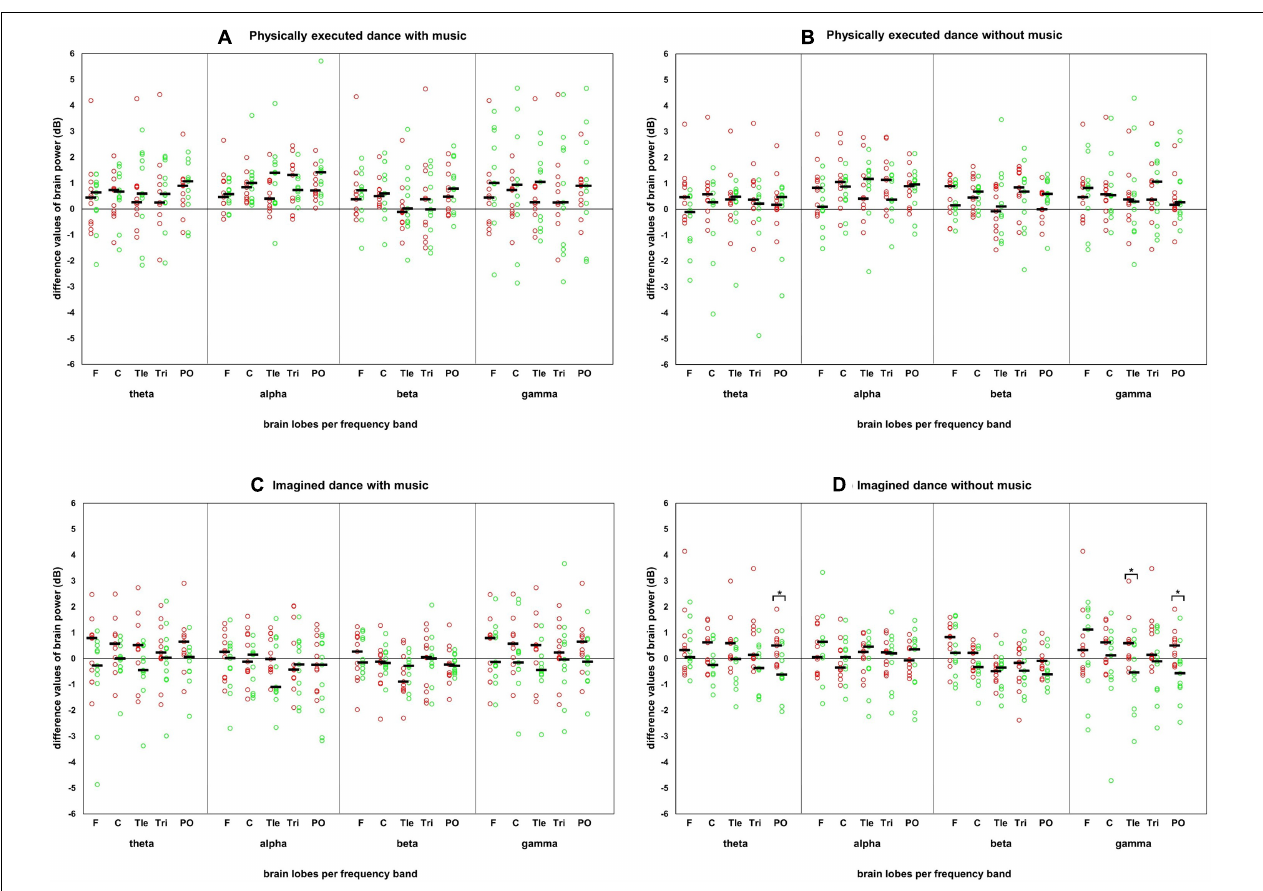
FIGURE 2 | Difference values of each participant in the test conditions in the power spectrum. Difference values of each participant in each test condition, frequency band, and brain lobe in the power spectrum with the presentation of the median. Red circles: individual difference values of the female participants. Green circles: individual difference values of the male participants. Black horizontal bar: median of each sex/gender. Brain lobes: F, frontal lobe; C, central lobe; Tle, temporal left lobe; Tri, temporal right lobe; PO, posterior lobe. Four test conditions in panels: (A) physically executed dance with music, (B) physically executed dance without music, (C) imagined dance with music, and (D) imagined dance without music. TABLE 2 | Significant within-sex/gender differences between test conditions of the power spectrum in men. Men χ 2 (df) b Global p b Diff-rest 1 (dB) c Diff-rest 2 (dB) c Post hoc comparisons da-m × im-m a Alpha PO 9.22 (3) 0.027 1.41 − 0.24 0.030 2.81 0.85 da × im a Beta C 9.87 (3) 0.02 0.68 − 0.33 0.018 2.97 0.90 Statistically significant differences between test conditions with the presentation of the Diff-rest values of the power spectrum. Left column, descriptive values; right column, statistical values. a Statistical differences between test condition pairs, da-m, physically executed dance with music; da, physically executed dance without music; im-m, imagined dance with music; im, imagined dance without music. b χ 2 with degrees of freedom of Friedman-test, r-value effect size of the Friedman-test, z-value of the Friedman-test. c Diff-rest 1, difference value from pre- to post-rest-measurement of the left test condition from test condition pair; Diff-rest 2, difference value from pre- to post-rest- measurement of the right test condition from test condition